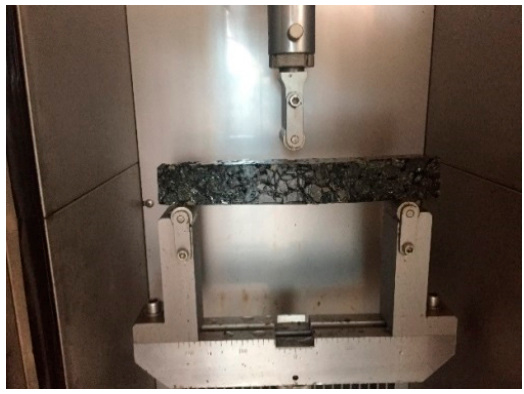
Figure 8. Bending test of specimen.